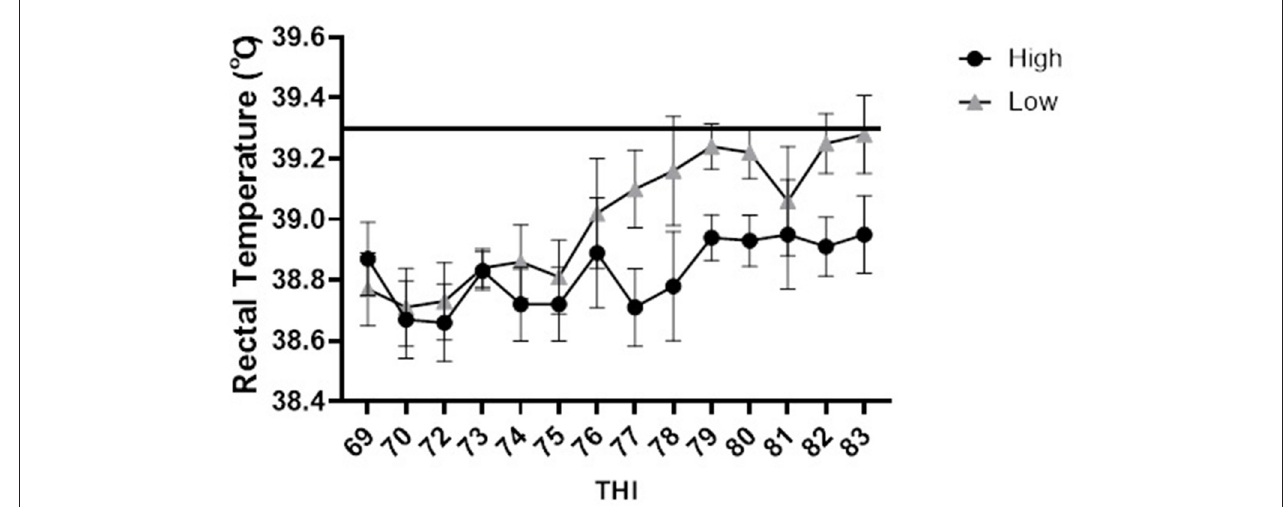
FIGURE 5 | Rectal temperature in degrees Celsius vs. temperature humidity index for high and low immune responding cattle housed in the tie-stall. Data are presented as least squared means of untransformed data, with error bars representing standard error for each mean. The line at 39.3 ◦ C represents the maximum normal rectal temperature for dairy cattle. No difference was observed between phenotypes at THI values, however there was a tendency ( p = 0.03) for high immune responder to have reduced rectal temperature across THI values compared to lows.